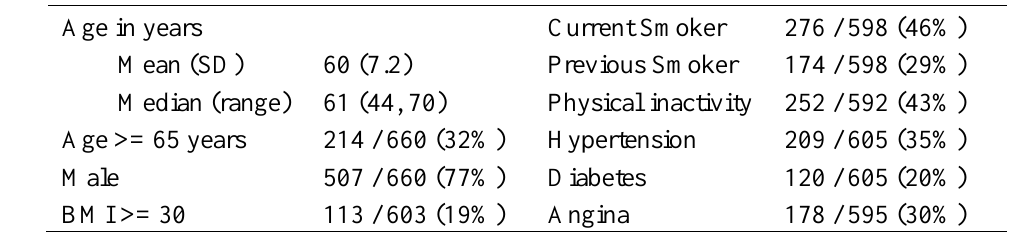
Table 1. Characteristics of myocardial infarction cases in the Stockholm Onset study (n = 660).